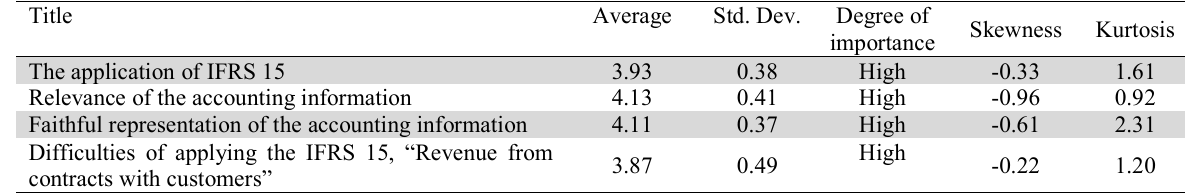
Std. Dev. Average